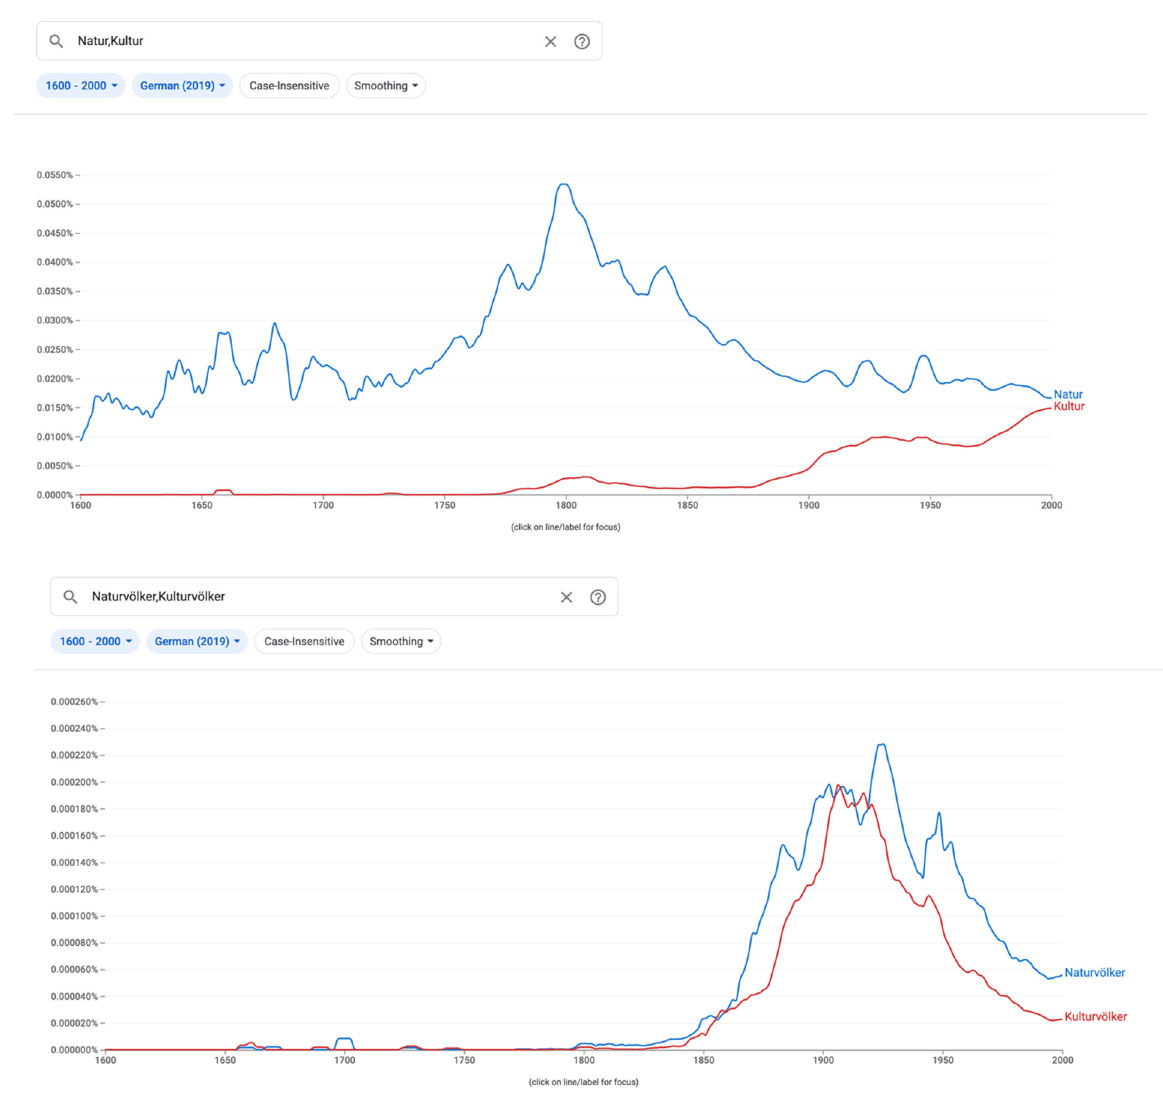
Figure 1. Word frequency of Natur/Kultur and Naturvölker/Kulturvölker in German printed matter. 1600–2000 (Google Books Ngram Viewer n.d.).